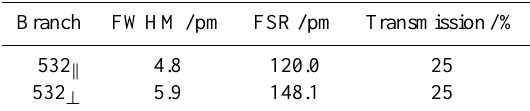
Table 4. Characteristics of cascaded detection in the 532-nm chan- nels.